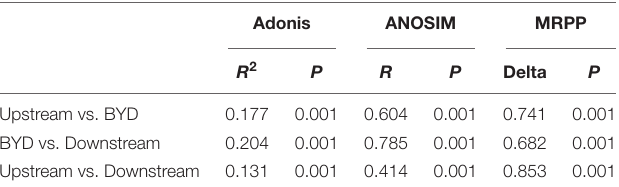
the network of upstream microeukaryotic communities had many keystone taxa playing as network hubs, module hubs, and connectors but do not have a well modular structure ( Supplementary Table 2 and Figure 6A ). On the contrary, the